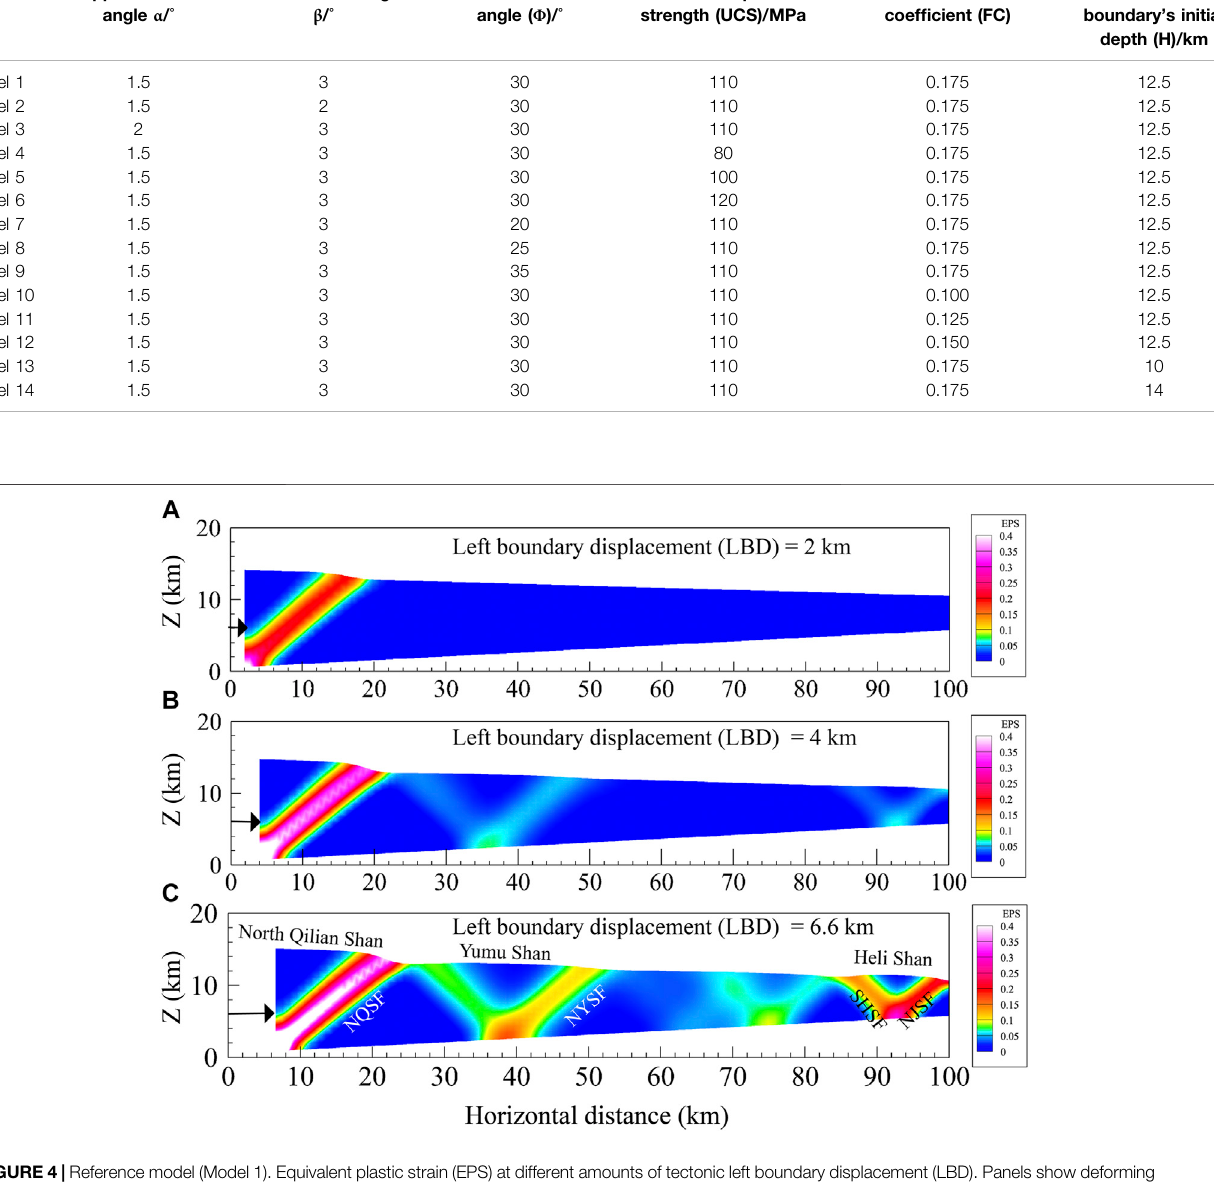
FIGURE 4 | Reference model (Model 1). Equivalent plastic strain (EPS) at different amounts of tectonic left boundary displacement (LBD). Panels show deforming wedge in initial reference frame. Colors map intensity of plastic strain, with pink-white zones being at maximum concentration of deformation where faulting would likely occur. Three panels display states of system at tectonic LBD (associated with horizontal shortening) (A) of 2 km; (B) of 4 km; (C) of 6.6 km. As horizontal contraction progresses in time, plastic-deformation zones develop from thick end toward thin end of wedge. In state (C) with 6.6 km of shortening, model suggests four main thrusts, likely approximating/reproducing real Earth ’ s NQSF: North Qilian Shan Fault, NYSF: North Yumu Shan Fault, SHSF: South Heli Shan Fault, and NJSF: North JintananShan Fault and three mountain ranges: North Qilian Shan, Yumu Shan, and Heli Shan and low-plasticity area(x ∼ 55 – 85 km) representing Jiudong Basin wedge region (consistent with Hu et al.,